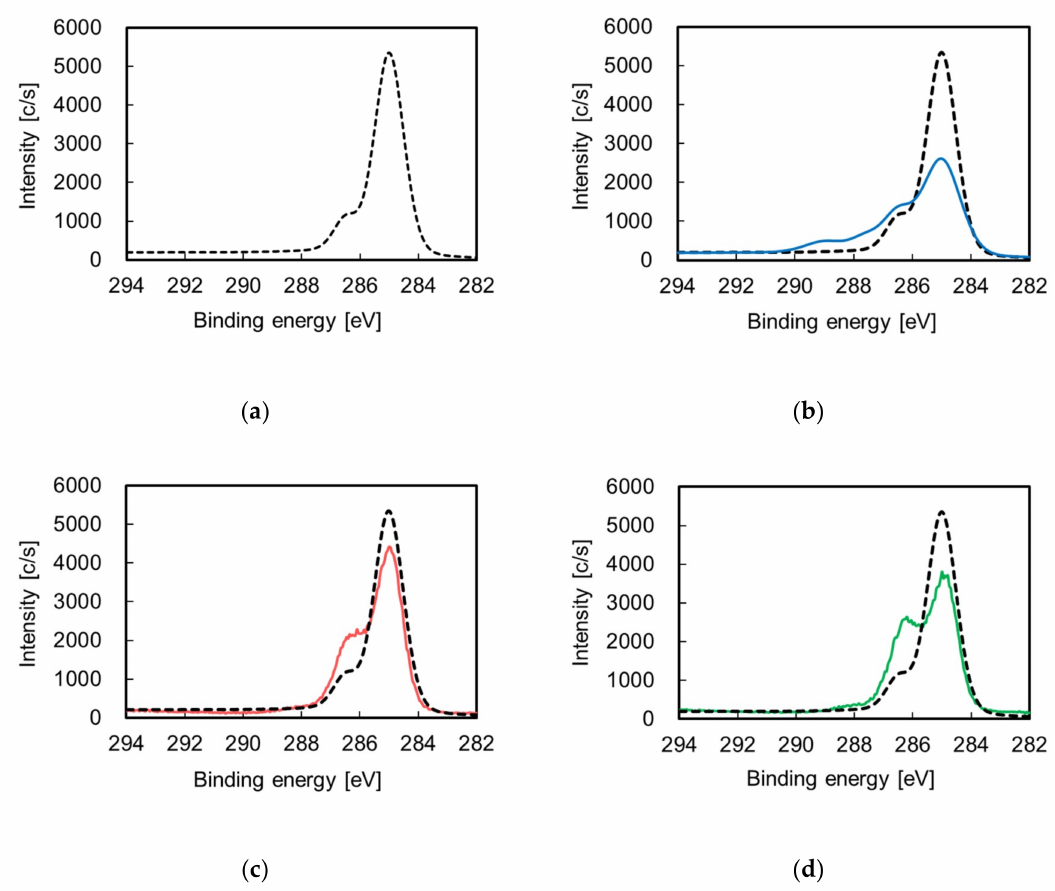
Figure 2. C1s-X-ray photoelectron spectroscopy (XPS) spectra of the ABS surface before (dotted lines) and after surface (solid colored lines): ( a ) ABS-untreated, ( b ) ABS-Etch, ( c ) ABS-Charge, and ( d )